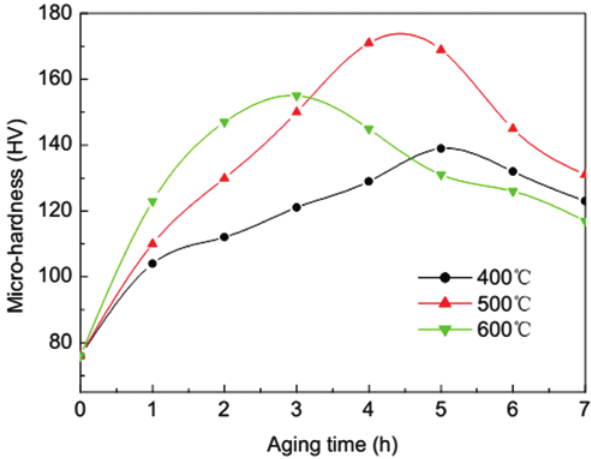
Figure 2: Curves of the microhardness with aging time and aging temperature.